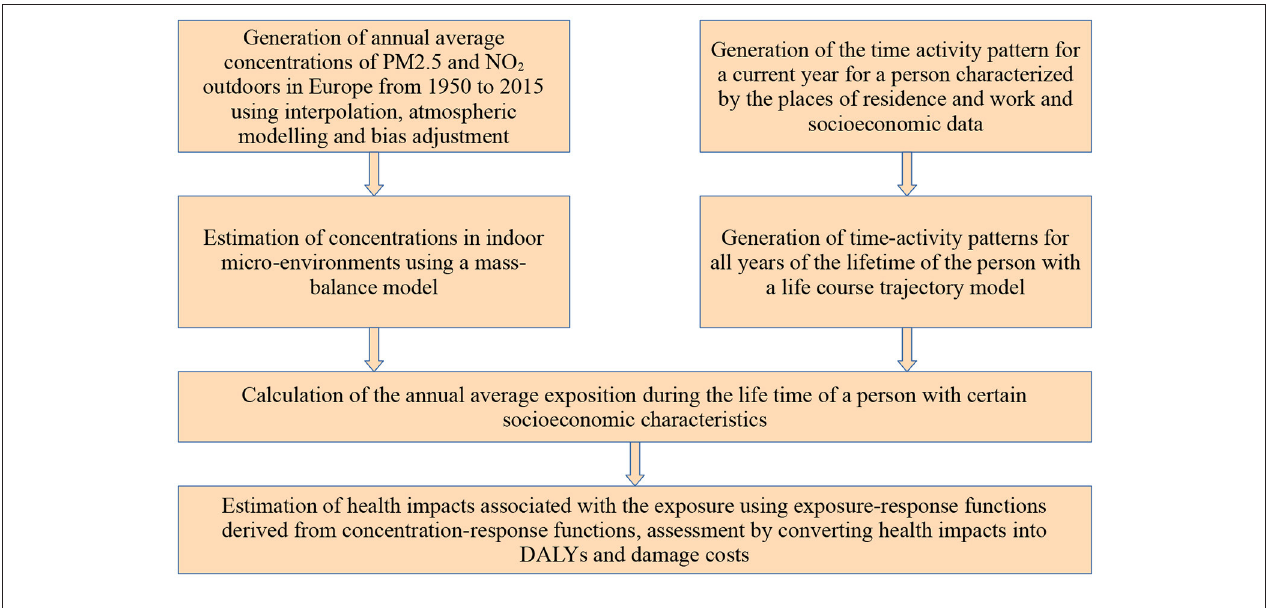
FIGURE 1 | Overall structure of the methodological